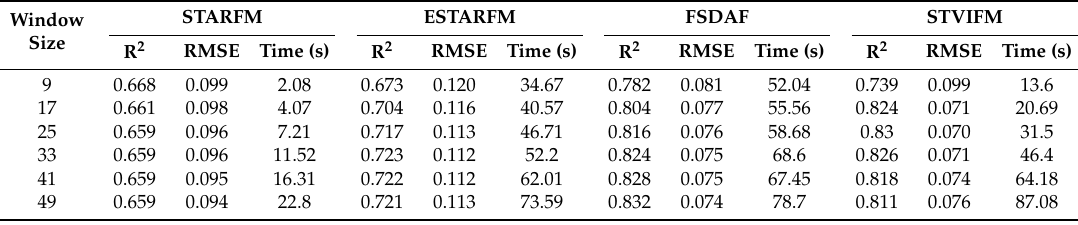
Table 2. Regression results between Landsat-8 NDVI image and correspondent synthetic NDVI image based on different algorithm using different window size at the Ontario